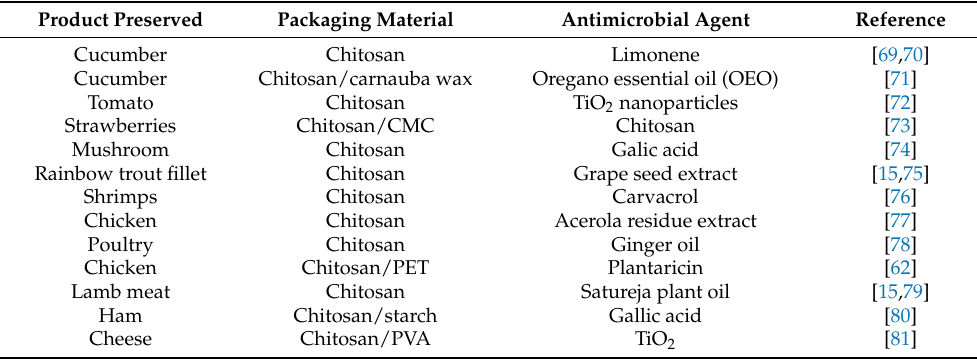
Table 1. Chitosan-based antimicrobial packaging and its potential